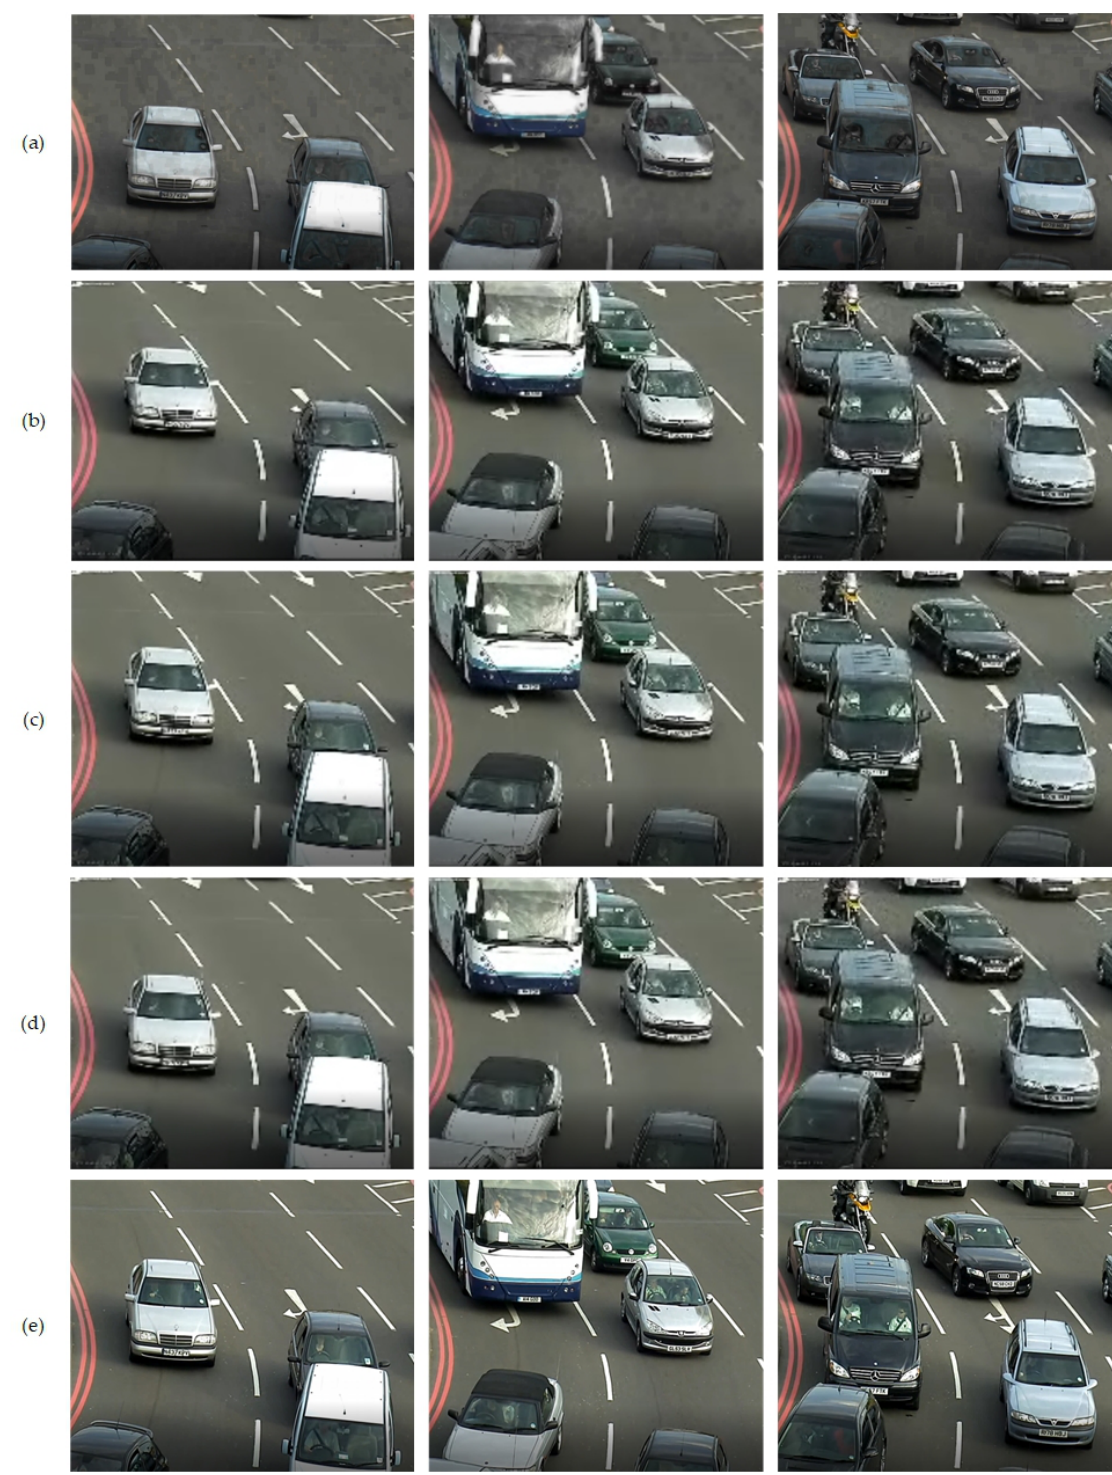
Figure 6. Input: ( a ) low-resolution; output of high-resolution video samples from IITH_Helmet2 dataset using: ( b ) DVD-GAN, ( c ) BigGAN, ( d ), BigGAN-deep and ( e ) proposed